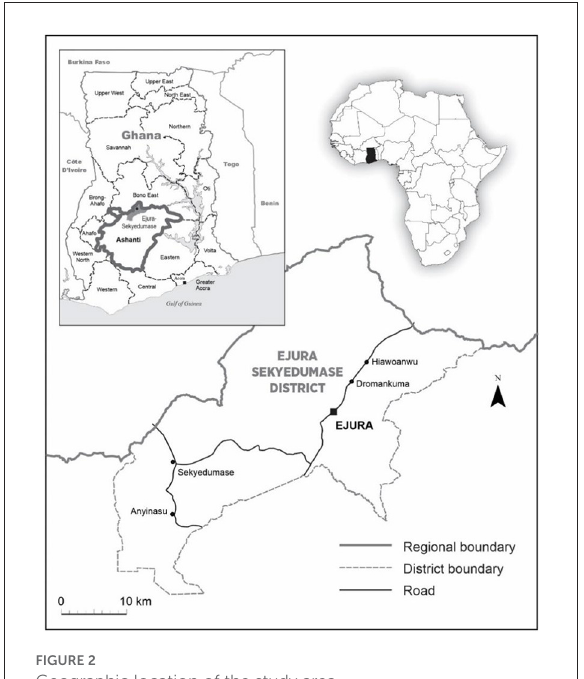
FIGURE2 Geographic location of the study